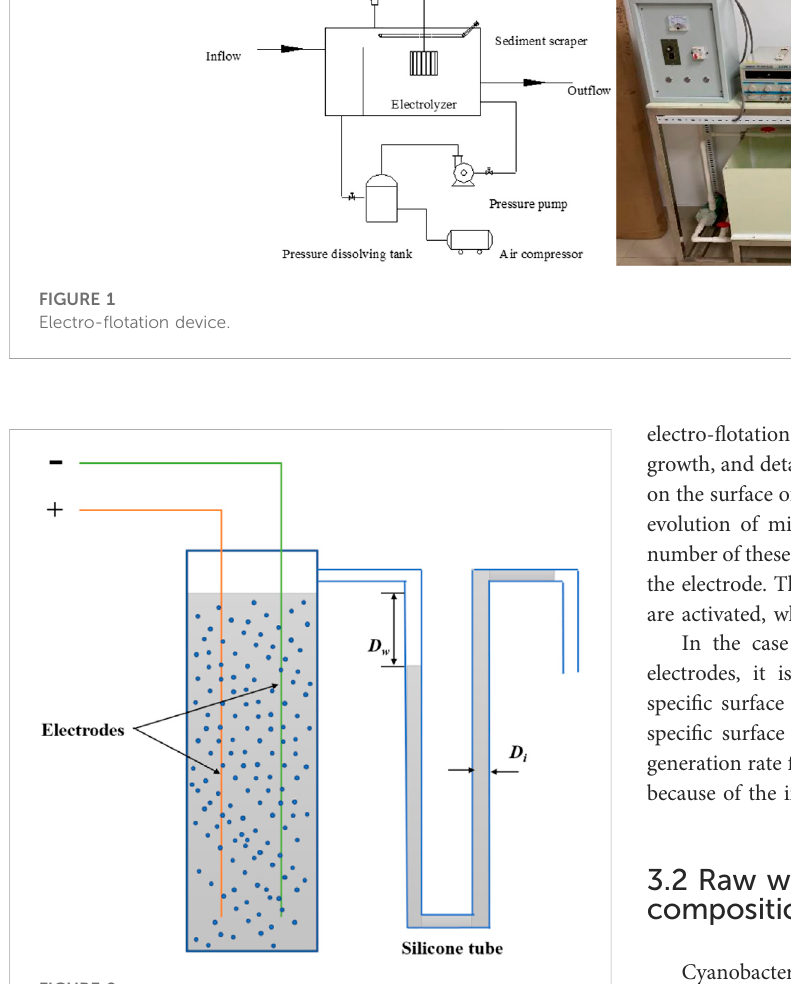
FIGURE 2 Schematic diagram of a microbubble volume measuring